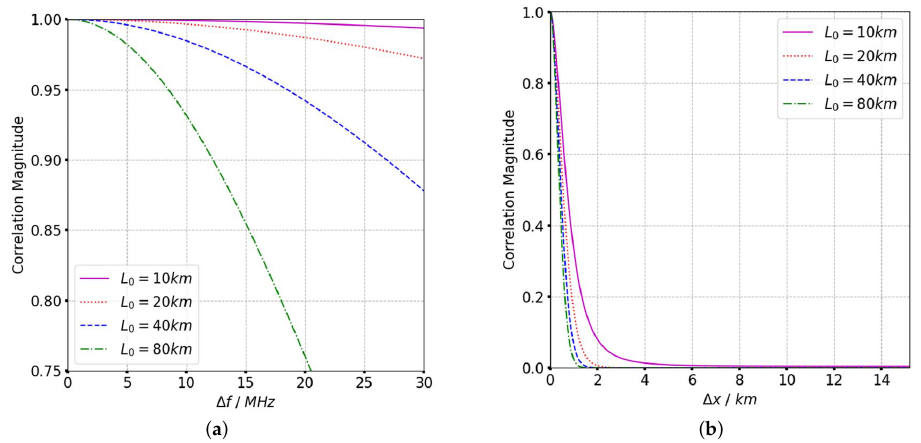
Figure 4. TFTPCF curves with different p . ( a ) TFTPCF versus frequency separation. ( b ) TFTPCF versus spatial separation.